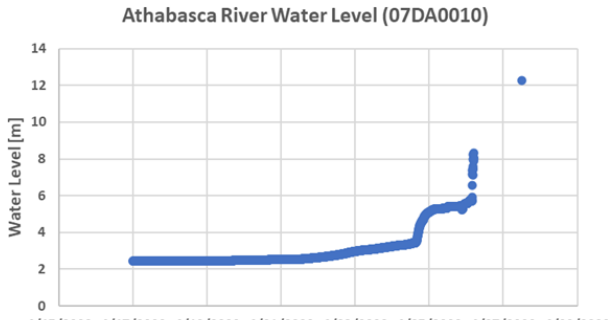
the last 2 weeks of April 2020.